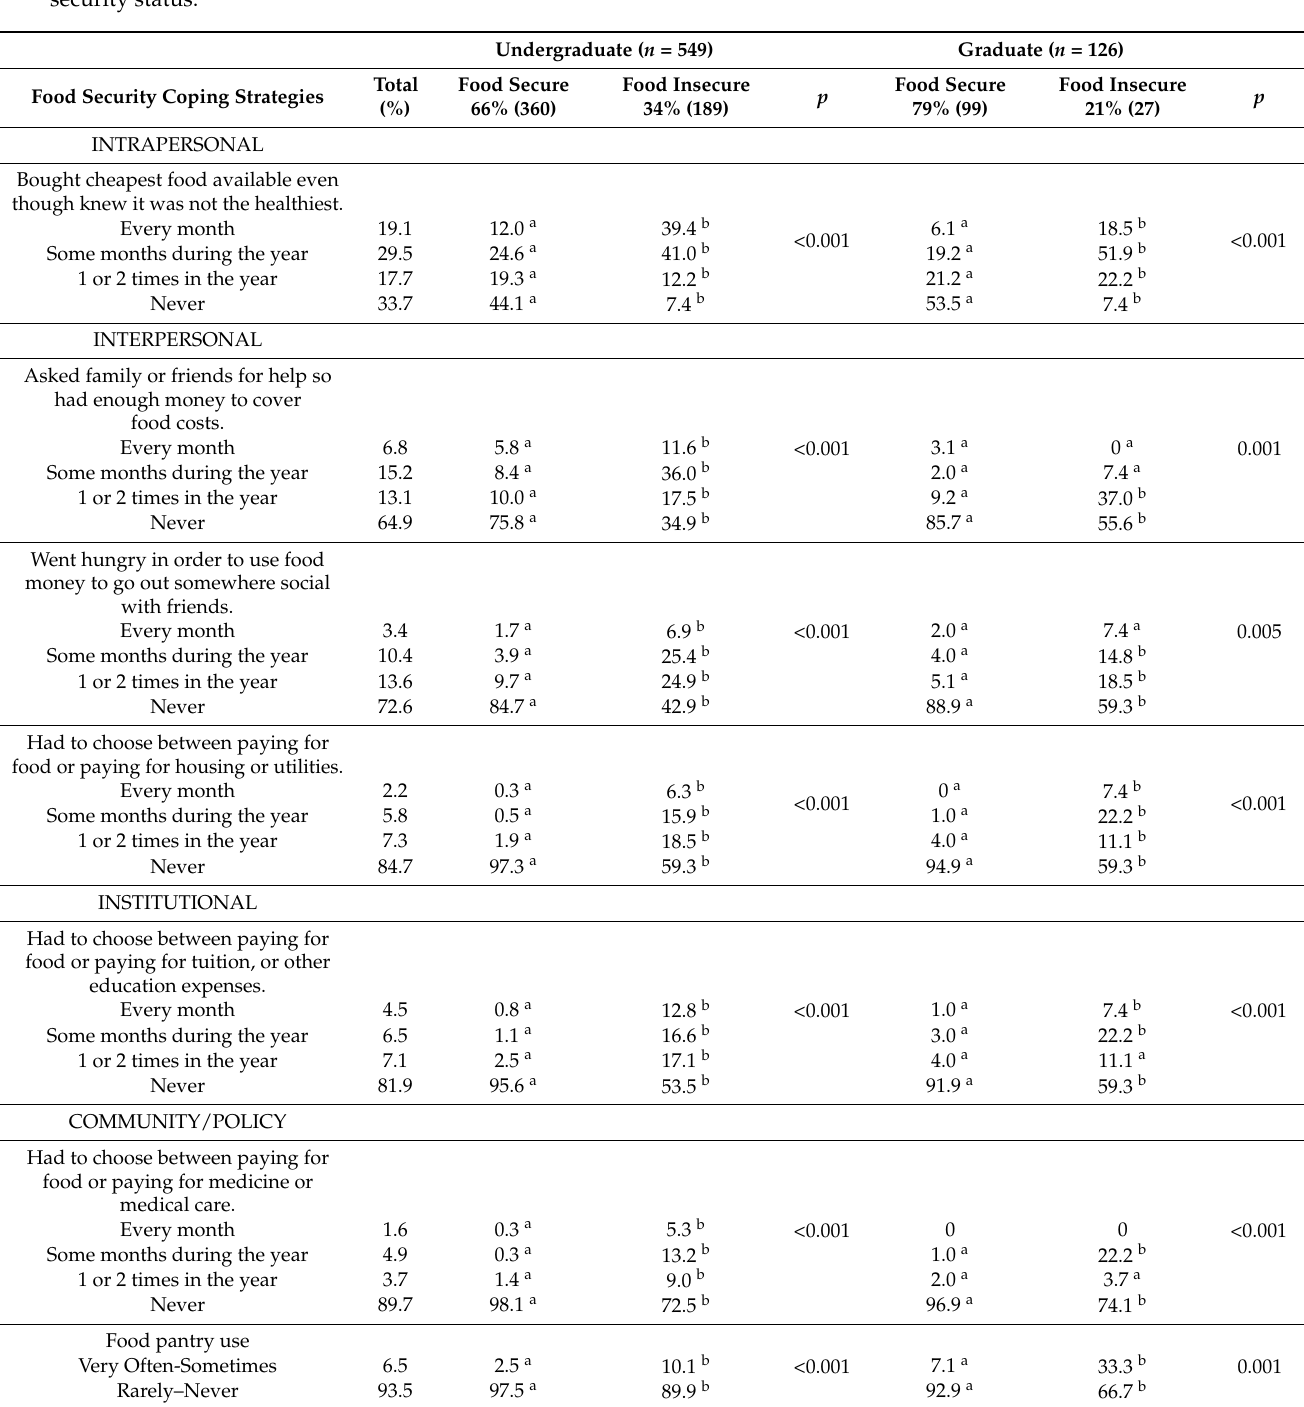
Table 3. Food security coping strategies for the past 12 months by midwest university students by academic and food security